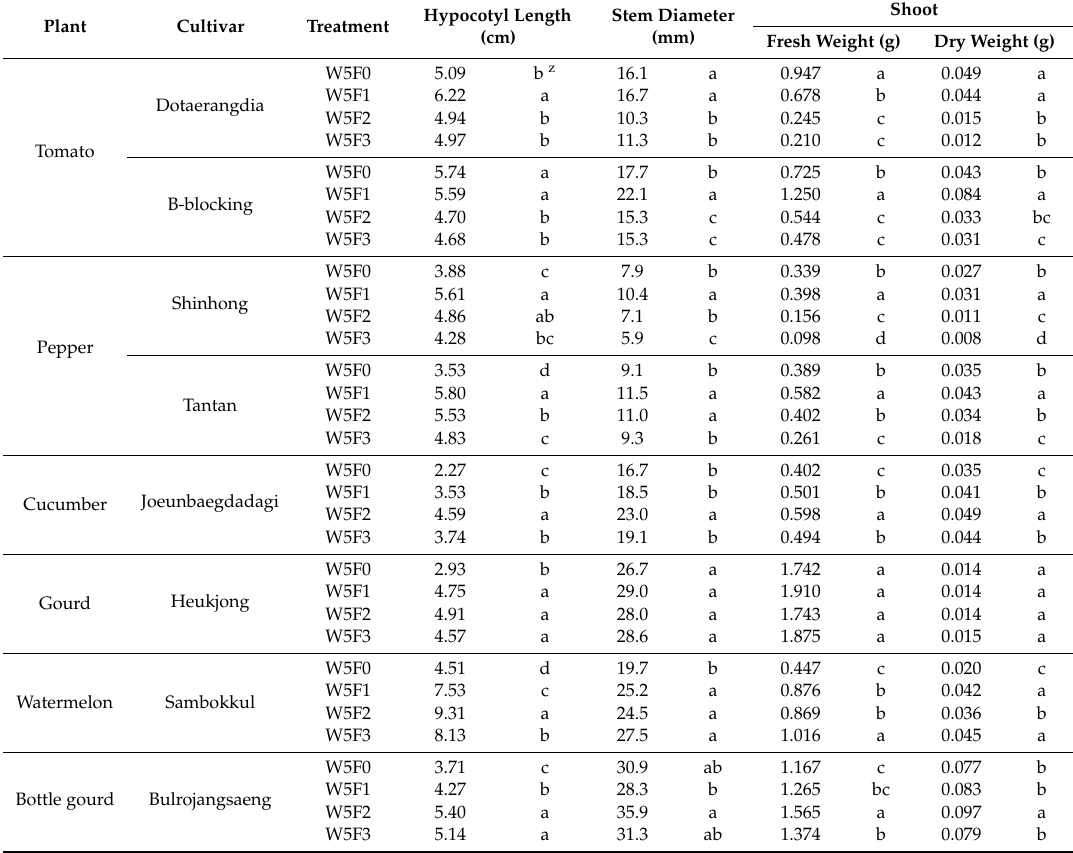
Table 2. Growth of tomato at 14 days after sowing (DAS), red pepper at 14 DAS, cucumber and gourd at 7 DAS and watermelon and bottle gourd at 9 DAS by the di ff erent supplemental far-red-LED-enriched lighting. Data represent the mean of three replications with eight plants per replication per